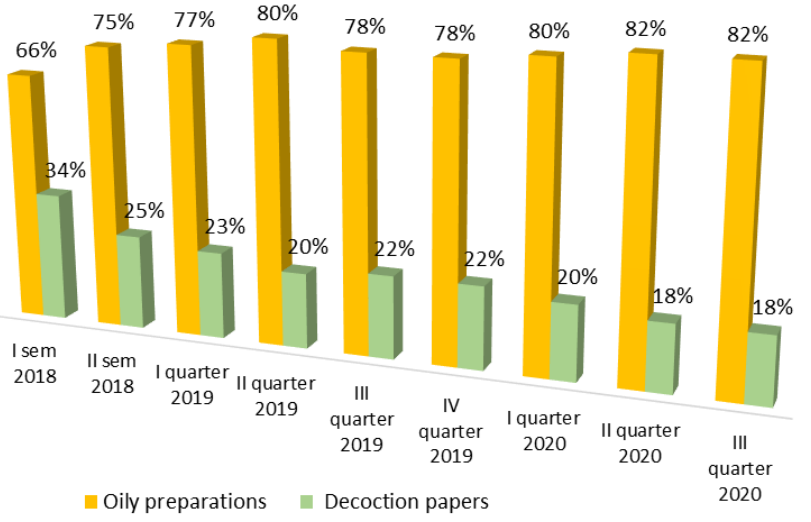
Figure 2. Distribution percentage of oily preparations and decoction papers, dispensed in Ligurian Region by the hospital pharmacist.